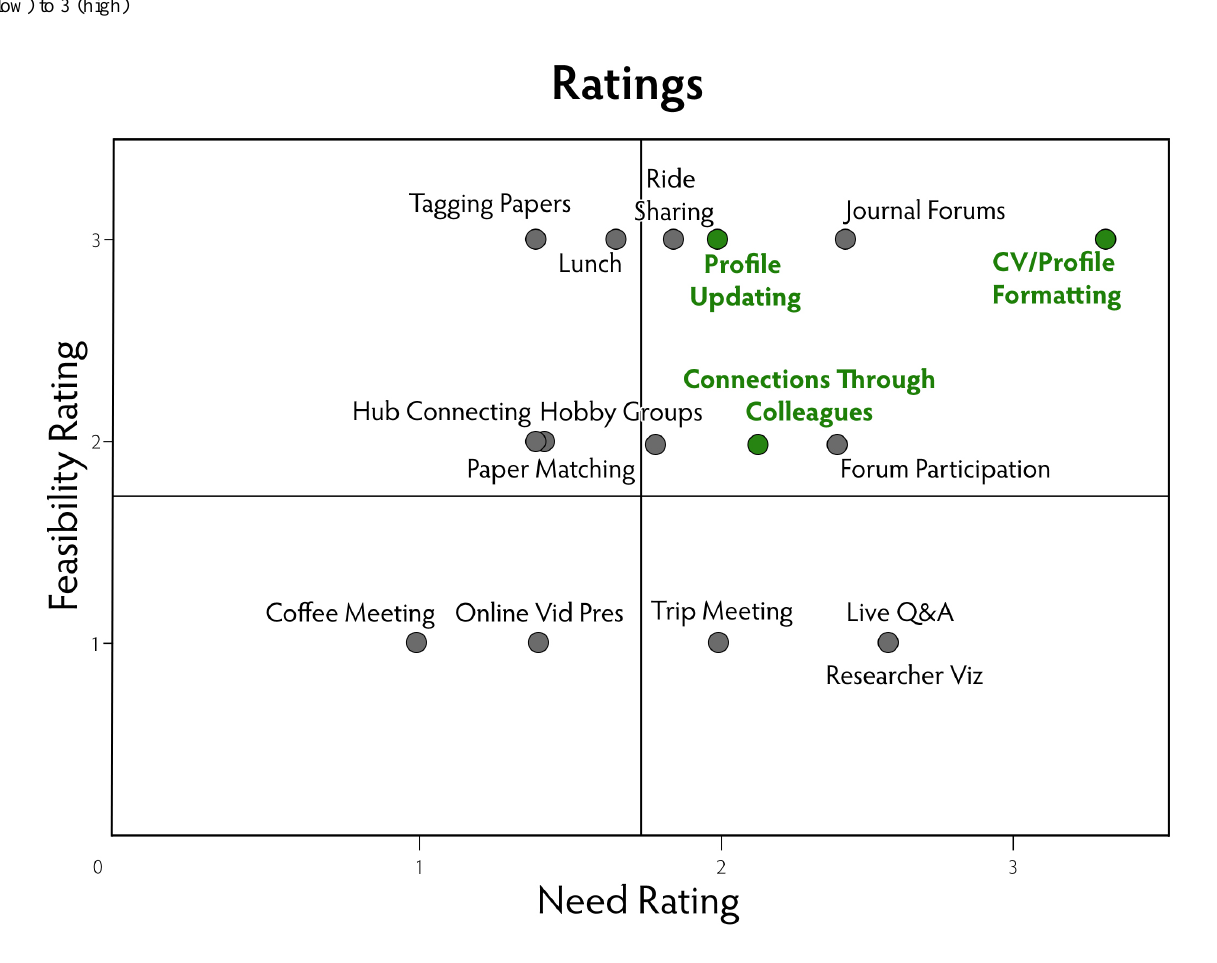
Figure 1. Results of the concept validation phase for 16 design ideas using nine scientist participants; need rating: 1 (low) to 4 (high); feasibility rating: 1 (low) to 3